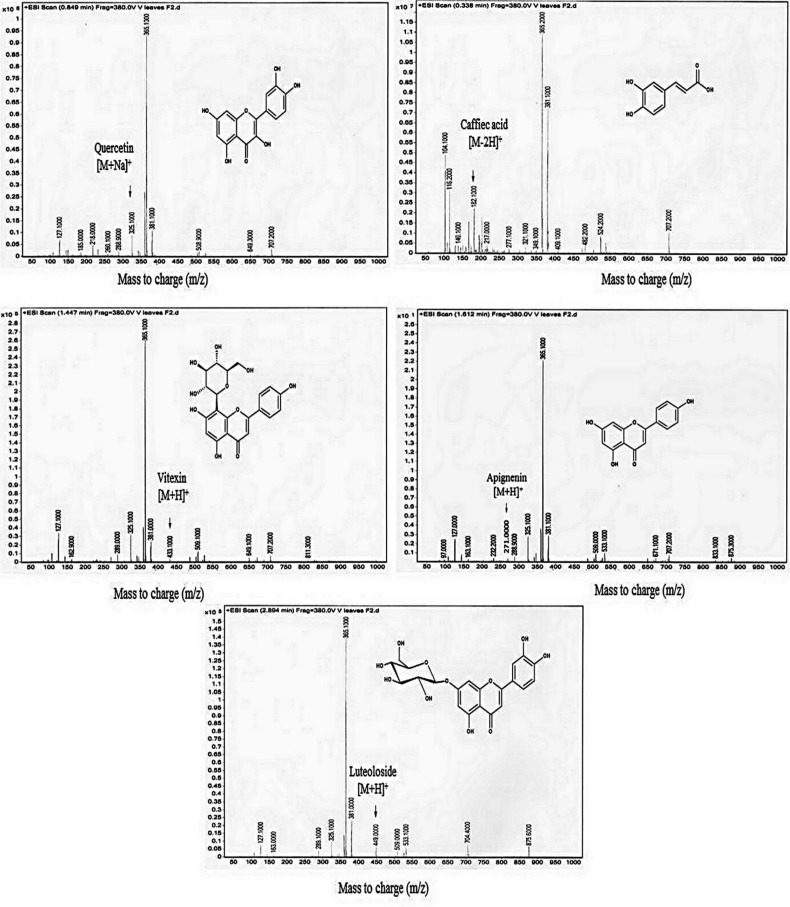
The Mass spectrum (Triple quad QQQ MS ESI+) and identified chemical structure in V. pubescens leaves, F2.